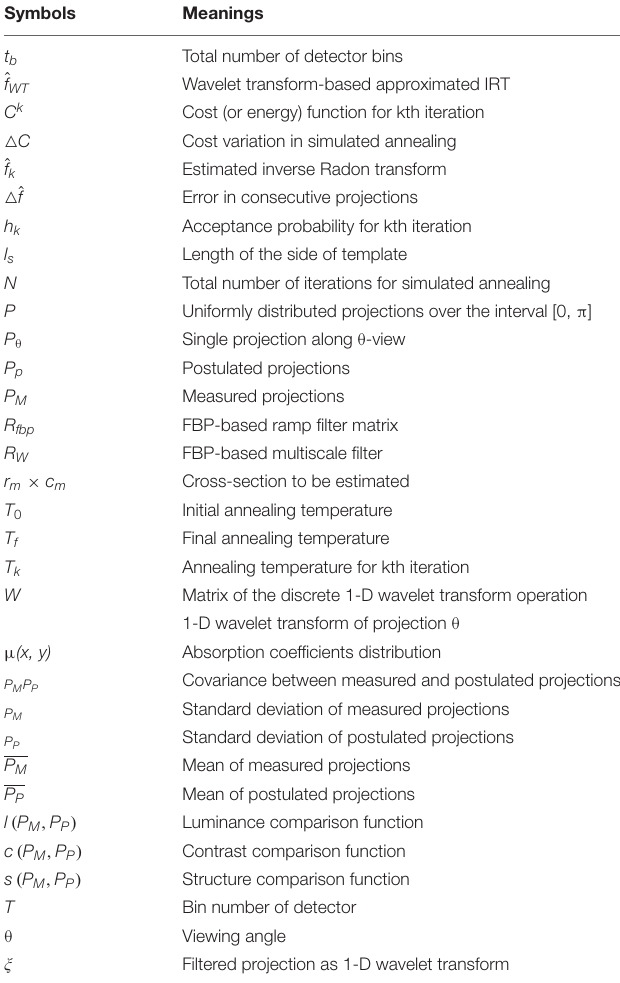
TABLE 2 | Mathematical notation summary for proposed low-dose CT-based image reconstruction system.